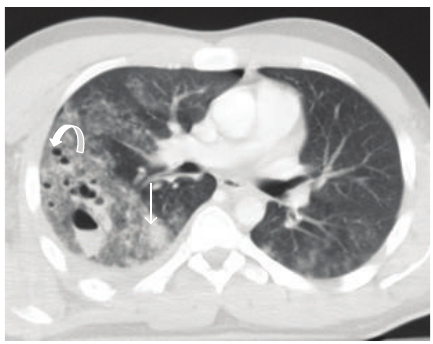
Figure 3: Pulmonary lacerations. Axial MDCT in lung window at the level of pulmonary trunk. Multiple focus of pulmonary lacerations can be depicted, some of them are filled with air (pneumatocele,curvedarrow),othersfilledwithblood(hematocele- straight arrow), and some filled with both, making an air-liquid level (pneumo-hematocele, arrowhead). Surrounding pulmonary contusions are appreciated. Associated left pulmonary contusions and a small right pneumothorax are also